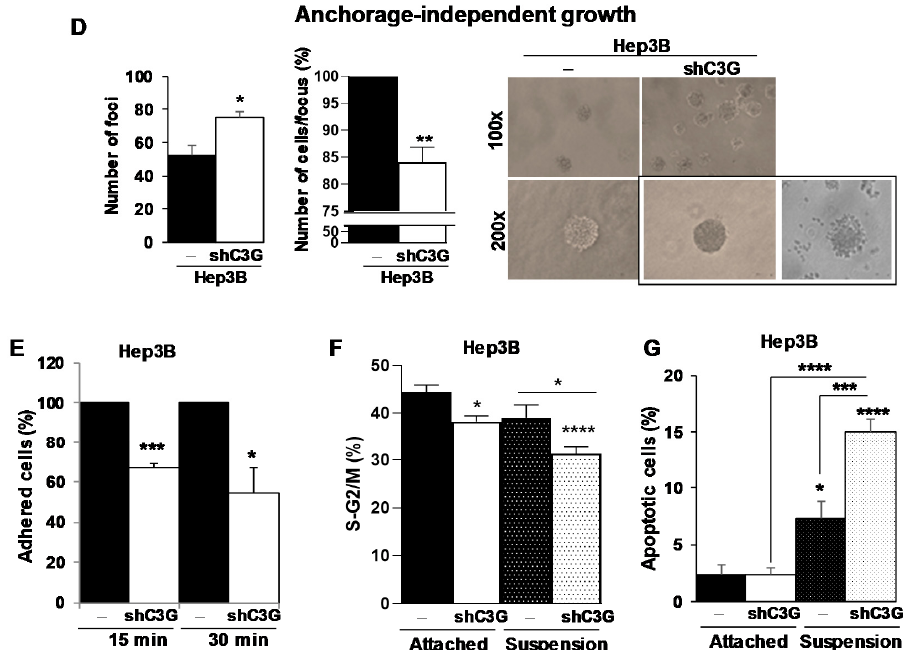
Figure 2. C3G knock-down reduces in vitro tumorigenic properties of HCC cells. Hep3B and HLE non-silenced ( − ) and C3G knock-down (shC3G) cells; and mHCC1 (non-silenced ( − ) and C3G knock-down (clones 2.17, 1.2 and 1.3)) were maintained in complete medium. ( A , B ) Top panels: Western-blot analysis of C3G expression in HCC cells, normalized with β -actin or tubulin. Middle panels: Representative macroscopic (whole dish) and microscopic (individual foci) photographs of anchorage-dependent growth assay. Bottom panels: Histograms show the mean ± S.E.M. of the number of foci (%) and the number of cells per focus (%). ( C ) Upper panels: Western-blot analysis of C3G expression in mHCC1 cells, normalized with β -actin. Middle panels: Representative macroscopic (whole dish) and microscopic (individual foci) photographs of anchorage-dependent growth assay. Lower panel: Histogram shows the mean ± S.E.M. of the number of foci. ( D ) Anchorage independent growth of Hep3B cells. Left panel: Histograms represent the mean ± S.E.M. of the number of foci (left) and cells per focus (right). Right panels: Representative microscope images of foci formation. ( E ) Adhesion assay in Hep3B cells. Histogram represents the mean ± S.E.M. of the percentage of adhered cells (%) after 15 and 30 min. Individual cells were counted with ImageJ. ( F ) Histograms showing the mean ± S.E.M. of the percentage of Hep3B cells in S+G2/M phases or ( G ) with a lower DNA content than 2C (apoptotic) analyzed by cytometry, when maintained in culture with 10% serum under adherent or suspension conditions for 6h. * p ≤ 0.05, ** p ≤ 0.01, *** p ≤ 0.001, **** p ≤ 0.0001, vs. non-silenced cells ( − ), ( A , B , D , E ) analyzed by Student’s t -test, ( A , B ) n > 3 or ( C , F , G ) one-way ANOVA; n ≥